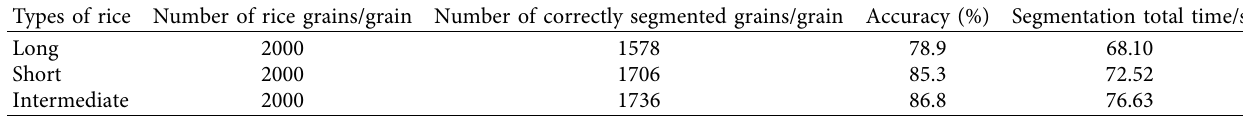
Table 2: The region growing algorithm segmentation result.